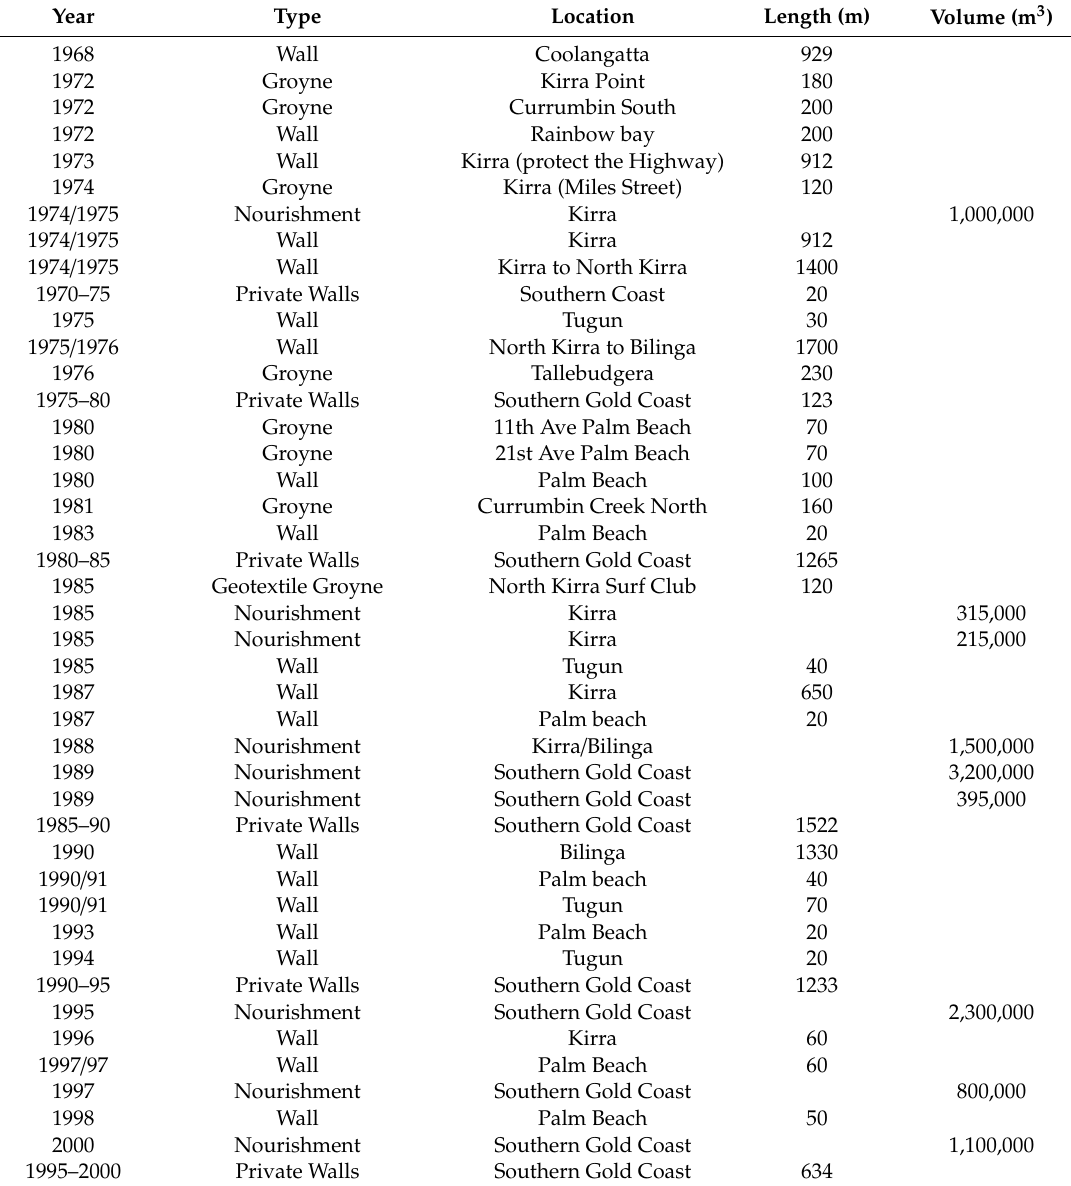
Table 1. Southern Gold Coast coastal protection